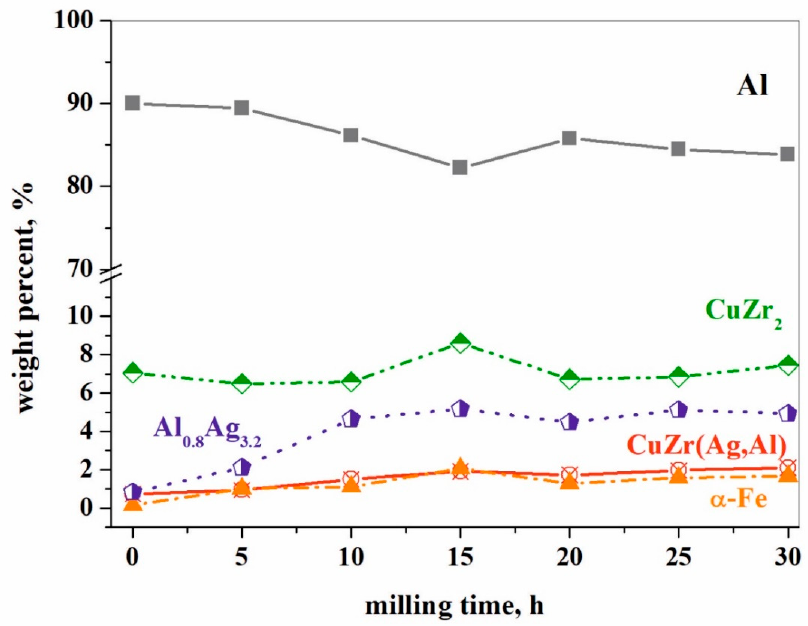
Figure 9. E ff ect of milling time on the weight fraction of di ff erent Figure 9. Effect of milling time on the weight fraction of different phases. Table 1. Features of the amorphous phase and the crystallites based on the XRD of raw and milled powder.